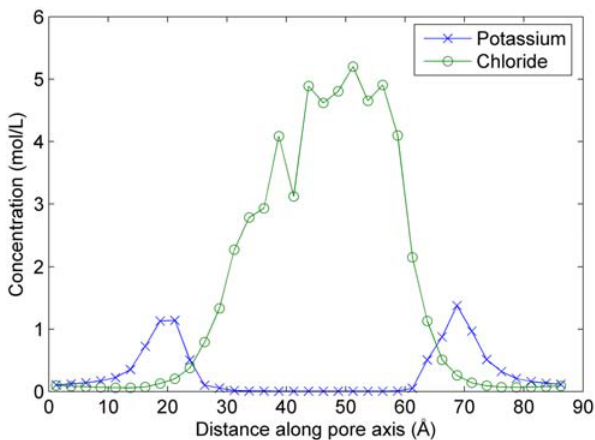
Figure 2. Concentration profiles of potassium and chloride. The values shown are averages over the x and y directions within the ion- accessible region. These profiles correspond to the PNP model applied to a snapshot at 93.5 ns of the NPT segment of the MD simulations of Langham et al., with an applied voltage of 2 20 mV, 0.1 M KCl bath concentrations, and diffusion coefficient profile D4.